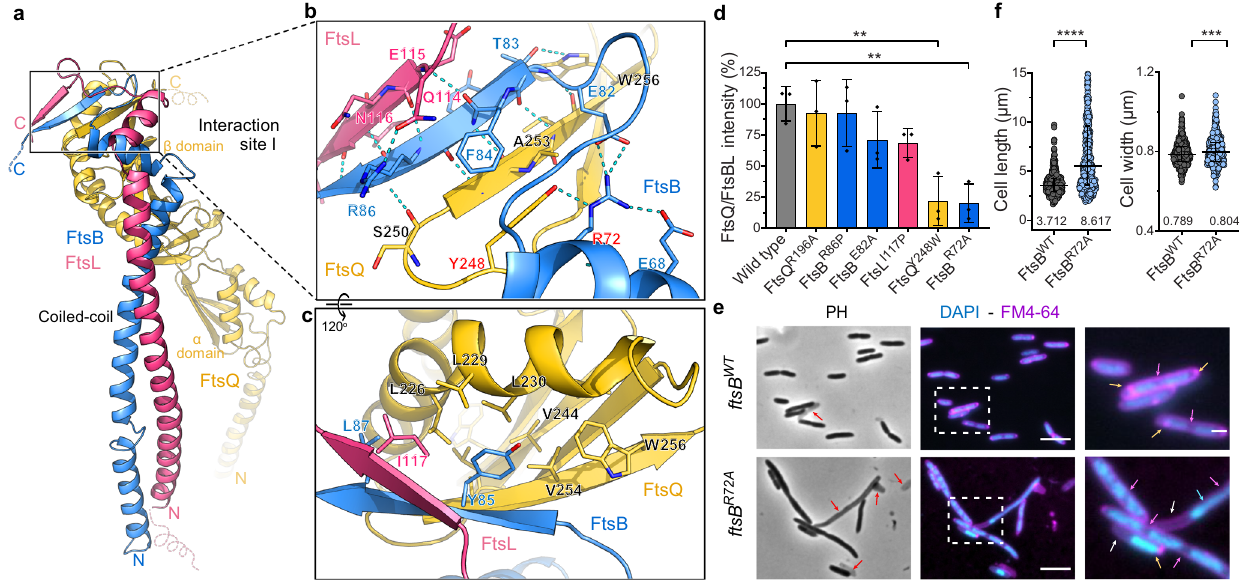
Fig. 3 | The C-terminal interaction site I of FtsB, FtsL, and FtsQ forms an extended β -sheet. a Overall structure of the FtsBLQ complex highlighting the C-terminal interaction site I in a box. FtsB: blue, FtsL: pink, FtsQ: yellow. b An enlargedview ofthe detailed interface as in the box in ( a ),showing the interacting residues in sticks and hydrogen bonds in blue dashed lines. Residues that affect complex formation are labeled in red. c A rotated view (120°) of ( b ) showing pri- marilyhydrophobicinteractions. d TheratioofFtsQoverFtsBLinthethree-protein co-puri fi cationwithdifferentmutationsaslisted(SupplementaryFig.2d).Theratio ofFtsQoverFtsBLinthewild-typecomplexisde fi nedas100%.Resultsarethemean intensity values of SDS-PAGE bands from three biological replicates. The compar- ison was performed by One-way ANOVA test. Data are presented as mean with SD.